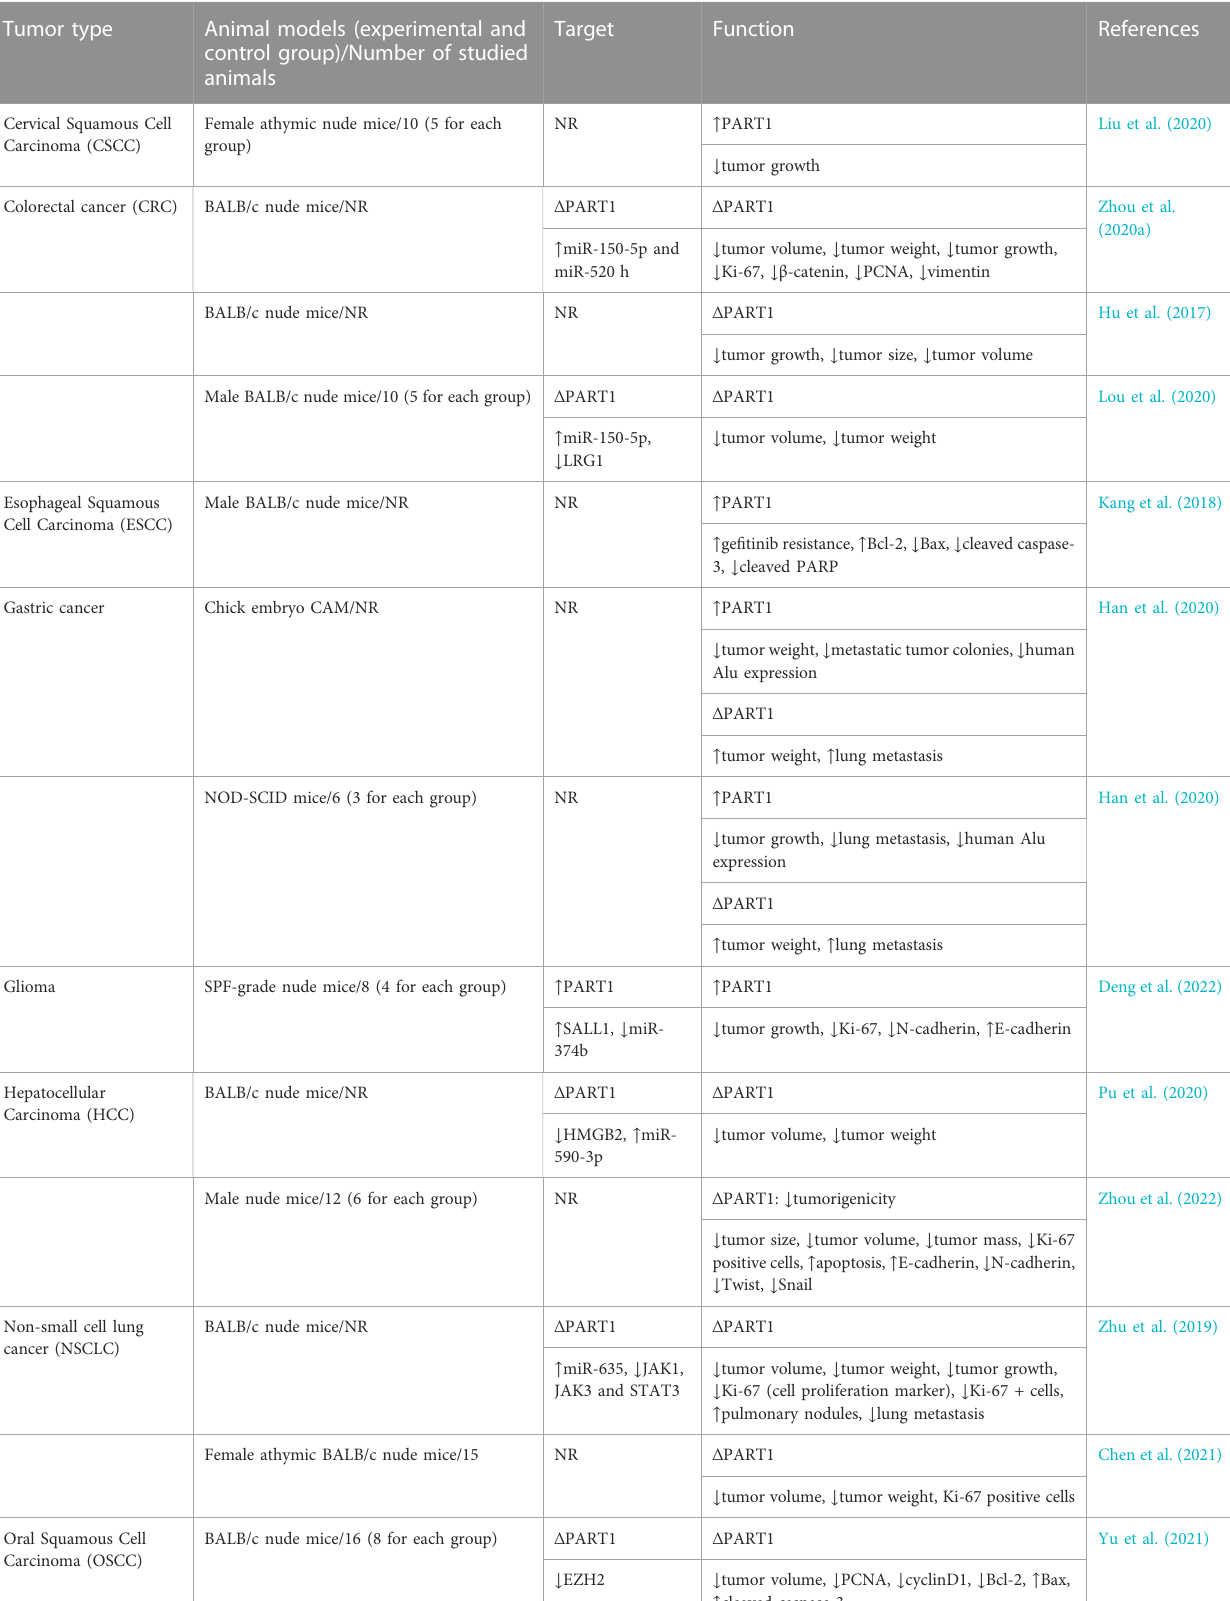
TABLE 3 Effects of PART1 in animal models for cancer ( Δ : knockdown or deletion, NR: not reported, CAM: chorioallantoic membrane, NOD-SCID mice: non-obese diabetic-severecombinedimmunode fi ciencymice,TUNEL:terminal deoxynucleotidyltransferasedUTPnickendlabeling,SPF:speci fi c-pathogen-free, ↑ :increase, ↓ :